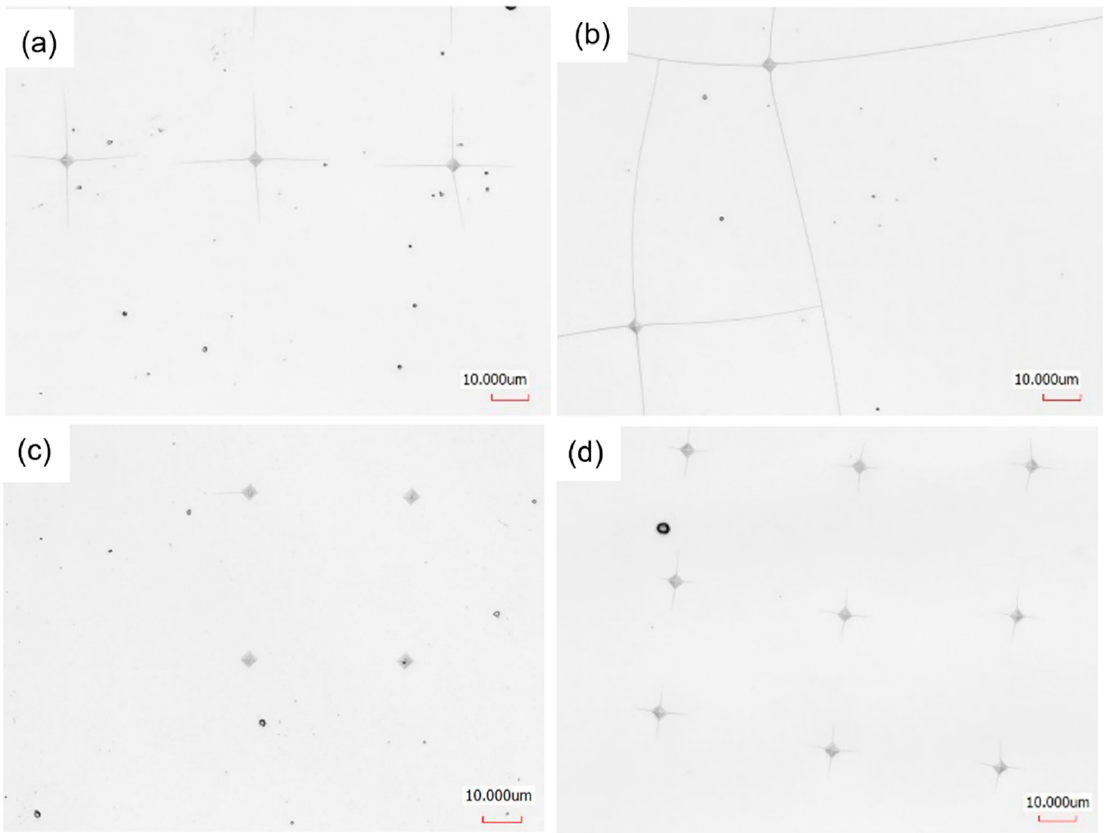
Figure 9. Confocal microscope micrographs of indented (HV 0.025 ) surface of coatings. ( a ) W-Cr-B, ( b ) W-Mo-B, ( c ) W-Re-B and ( d ) W-Zr-B.